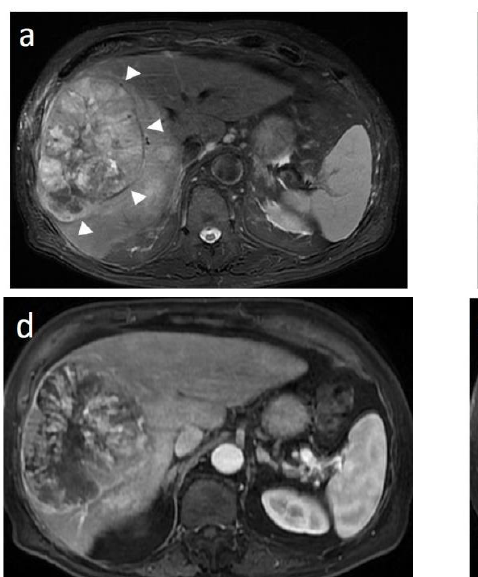
Figure 12. A large HCC is depicted in the right liver lobe of this 81-year-old man. The tumor is surrounded by a capsule, nicely seen as a thin, low signal line on the fat-suppressed T2 sequence (arrowheads) ( a ) and shows inhomogeneous but predominantly high T2 signal intensity. Areas of fat are clearly shown in the in/out of phase images (asterisk) ( b , c ). This marked heterogeneity is known as the “mosaic” pattern. After contrast administration, mottled arterial enhancement is noted ( d ); definite wash-out and capsular enhancement (arrows) are seen on the portal phase ( e ).